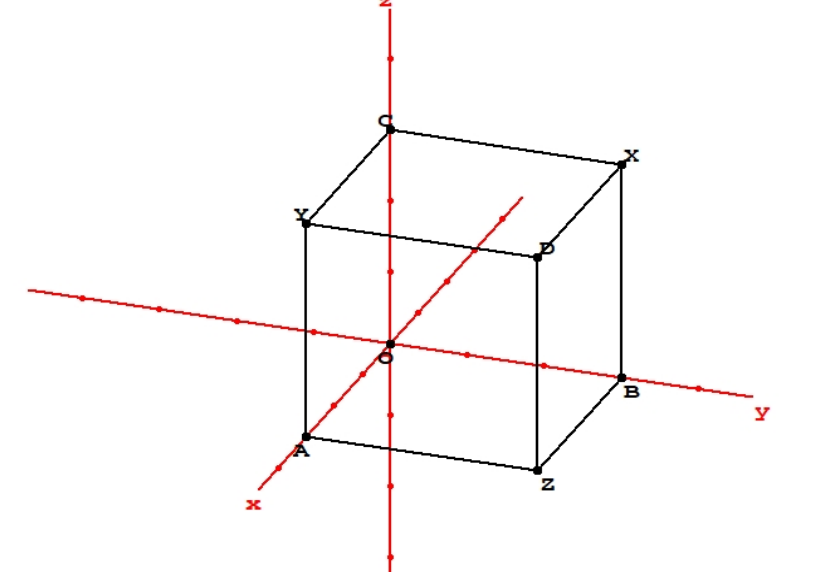
Figure 1. The summits of the cube are named to allow describing the density of utility in the tractable